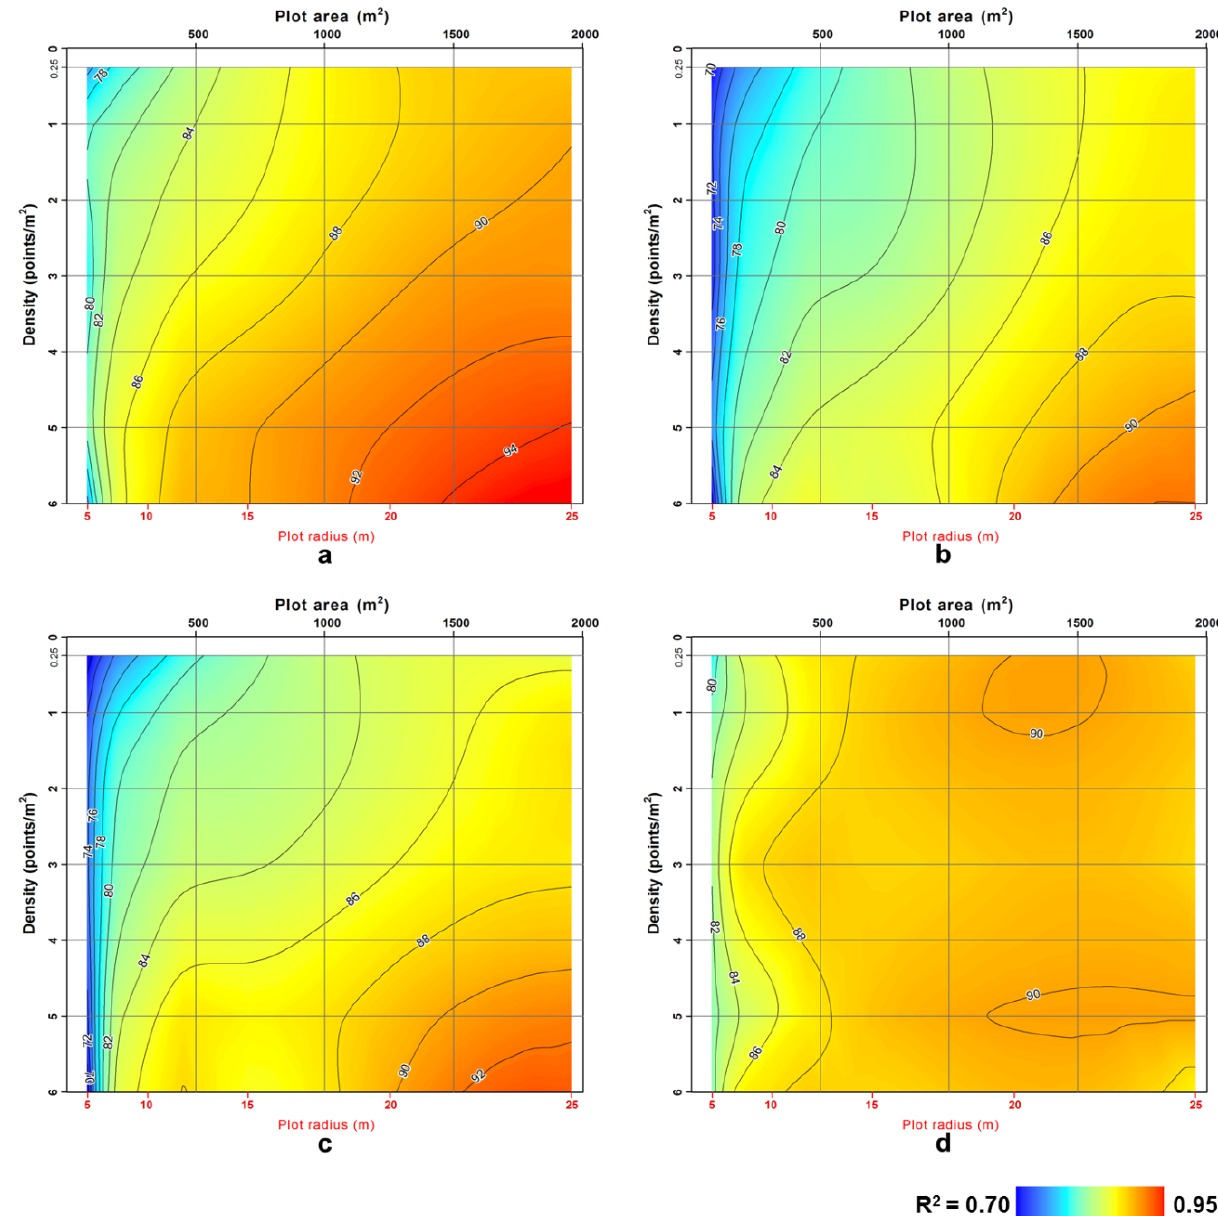
Figure 5. Variation of the coefficient of determination (%) as a function of the parameters plot size and LiDAR data density for forest stand attributes: ( a ) volume; ( b ) total biomass; ( c ) basal area; and ( d ) canopy